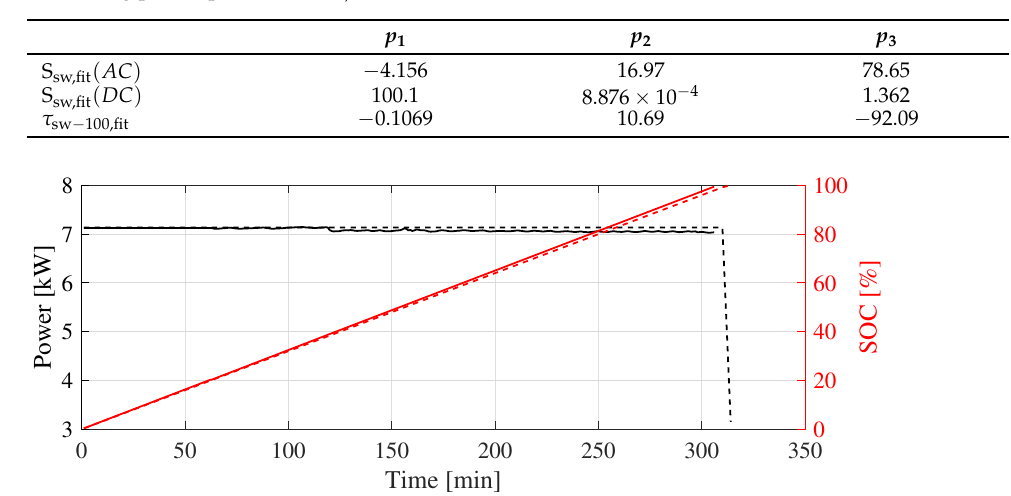
Table 4. Parameter values and RMSE for fitted curves, for calculating S sw,fit and the time share for decreasing power phase τ sw − 100,fit .